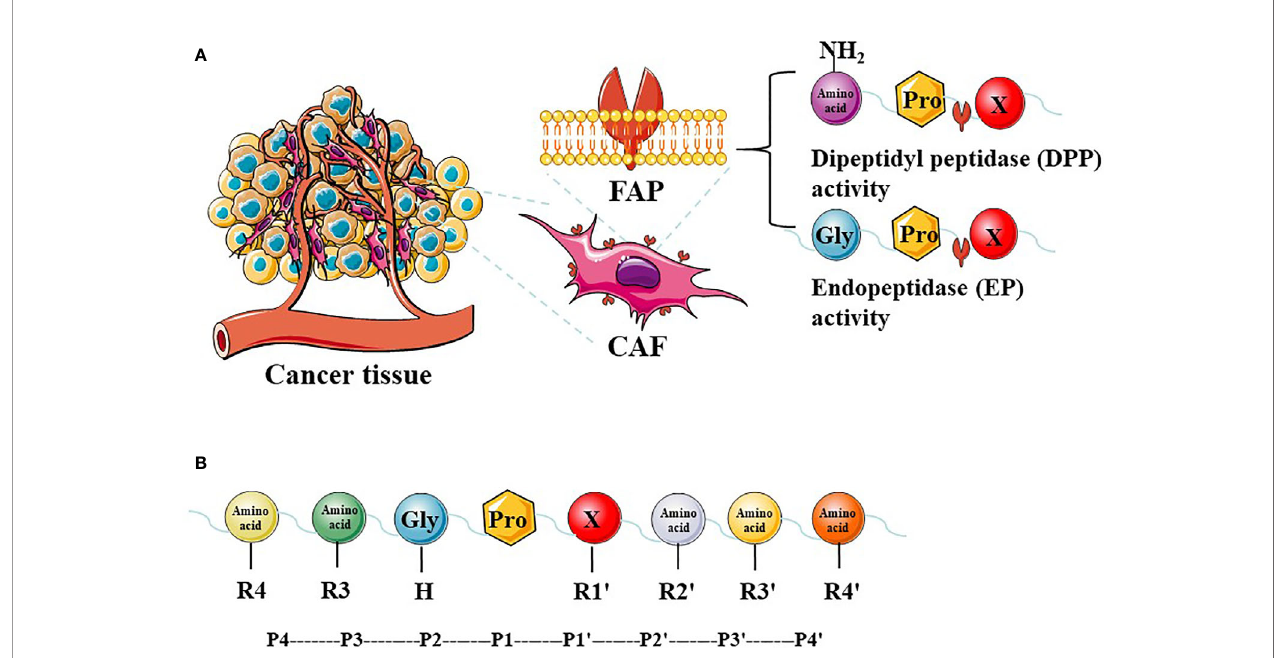
FIGURE 1 | The expression of FAP in tumor tissues and FAP enzyme activity. Cancer-associated fi broblasts (CAFs) express high levels of fi broblast activation protein- a (FAP). FAP has dipeptidyl peptidase (DPP) and endopeptidase (EP) activity (A) . The P2 preferences depend on the type of enzymatic activity, and different amino acids at different positions have a greater impact on enzyme activity (B)